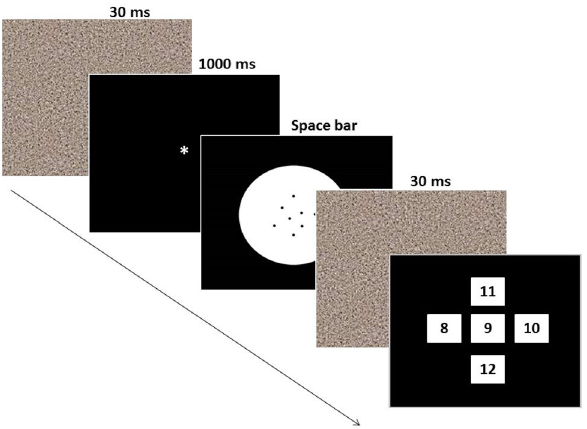
Figure 8. The task